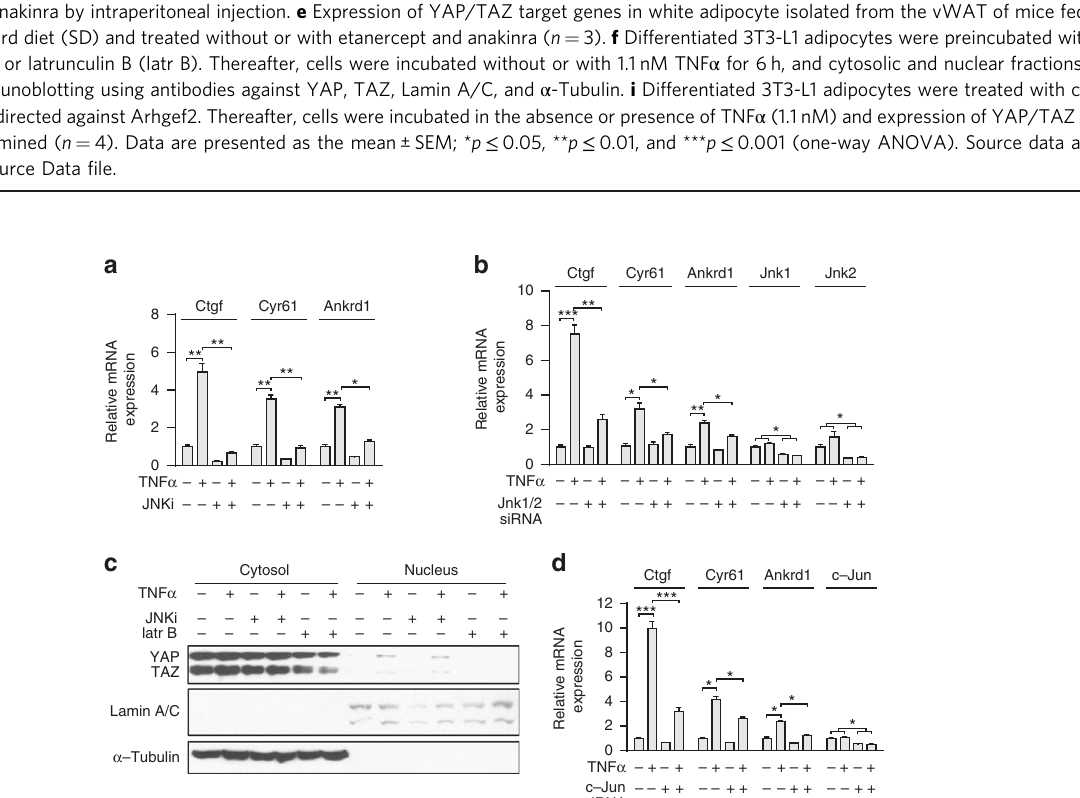
Fig. 5 TNF α regulates YAP/TAZ transcriptional activity in adipocytes. a Quantitative RT-PCR showing mRNA expression of YAP/TAZ target genes in response to TNF α (1.1 nM), IL-1 β (5.9 nM), IL-6 (0.8 nM), CCL2 (1.2 nM), and palmitic acid (p.a., 500 nM) in differentiated 3T3-L1 adipocyte ( n = 3 per group). b Differentiated 3T3-L1 adipocytes were incubated without or with 1.1 nM TNF α for 6 h, then cytosolic and nuclear fractions were analyzed by immunoblotting using antibodies against YAP/TAZ, α -Tubulin (cytoplasmic marker), and Lamin A/C (nuclear marker). The dashed line indicates the